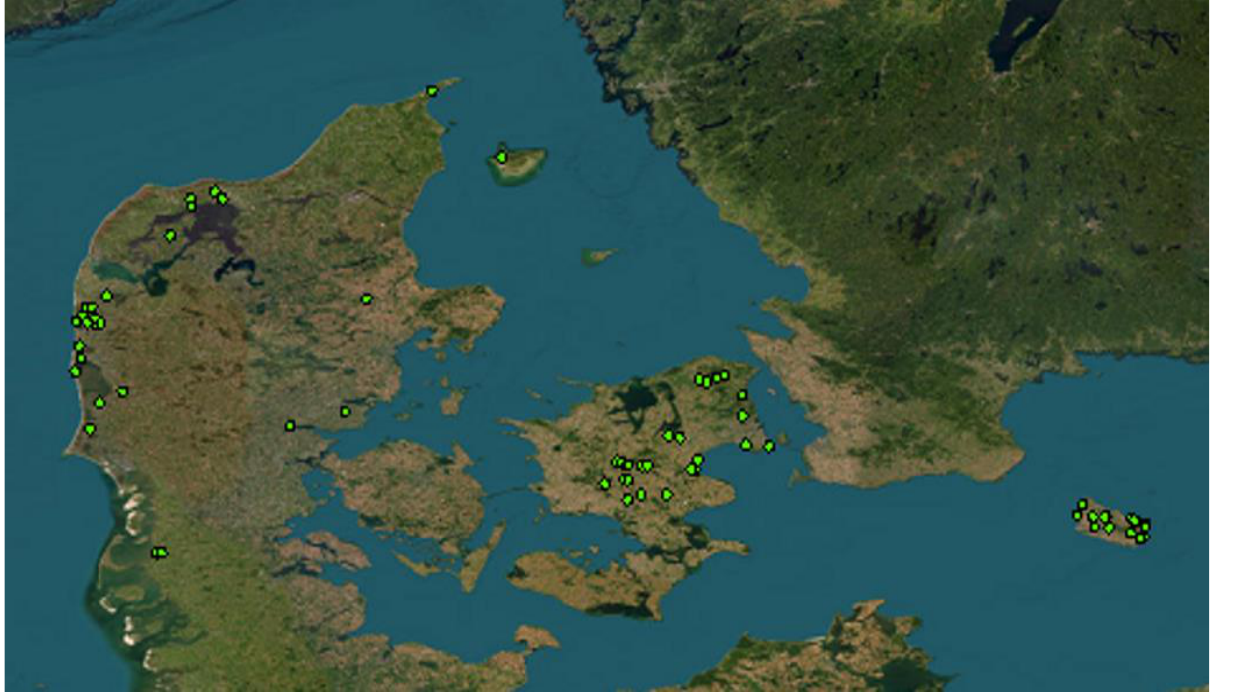
Figure 1. A map of Denmark showing Jutland, Zealand, and Bornholm as well as the geographical distribution of mink (green dots) caught by hunters during this study.